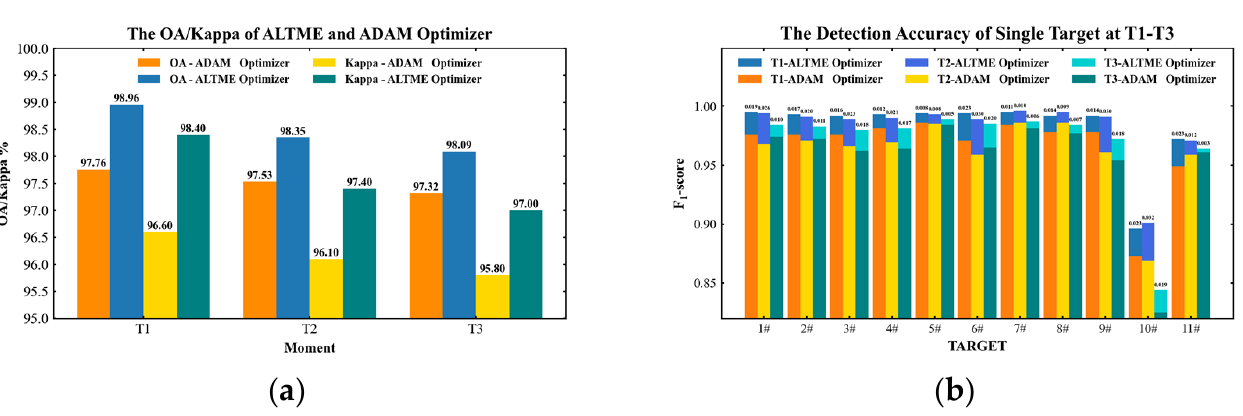
Figure 14. Comparison of the detection accuracy of the marine oil spill detection model with the ALTME and Adam optimizers. ( a ) OA and Kappa coefficient of the detection results and ( b ) single accuracy F 1 -score of the detection results.